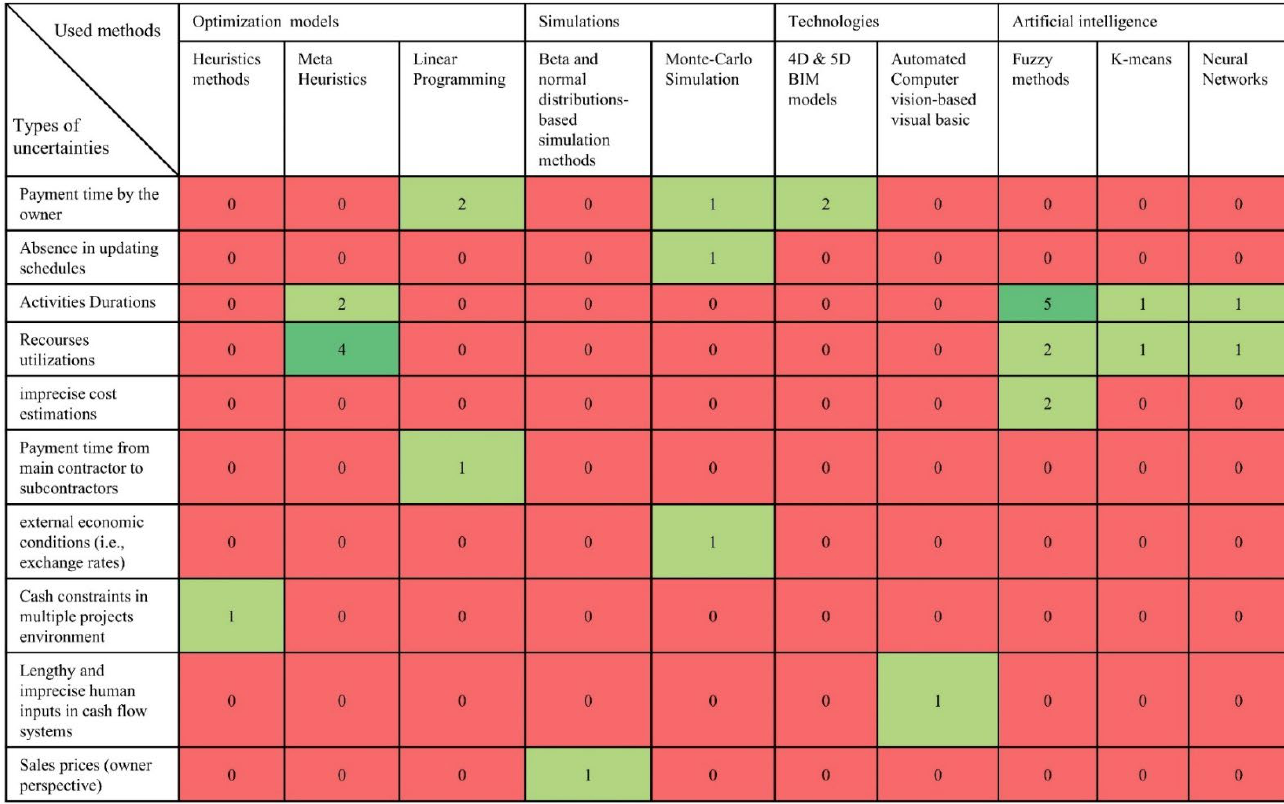
Figure 8. Types of the uncertainties integrated with cash flow and the used methods .